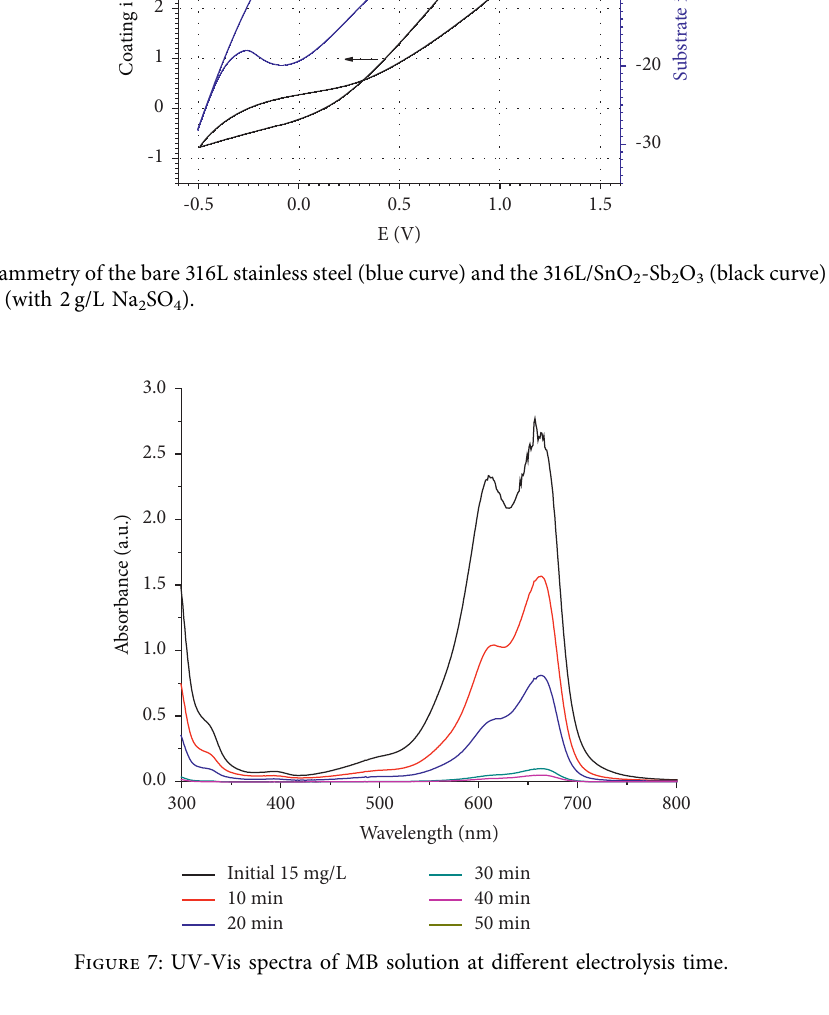
Figure 7: UV-Vis spectra of MB solution at different electrolysis time.